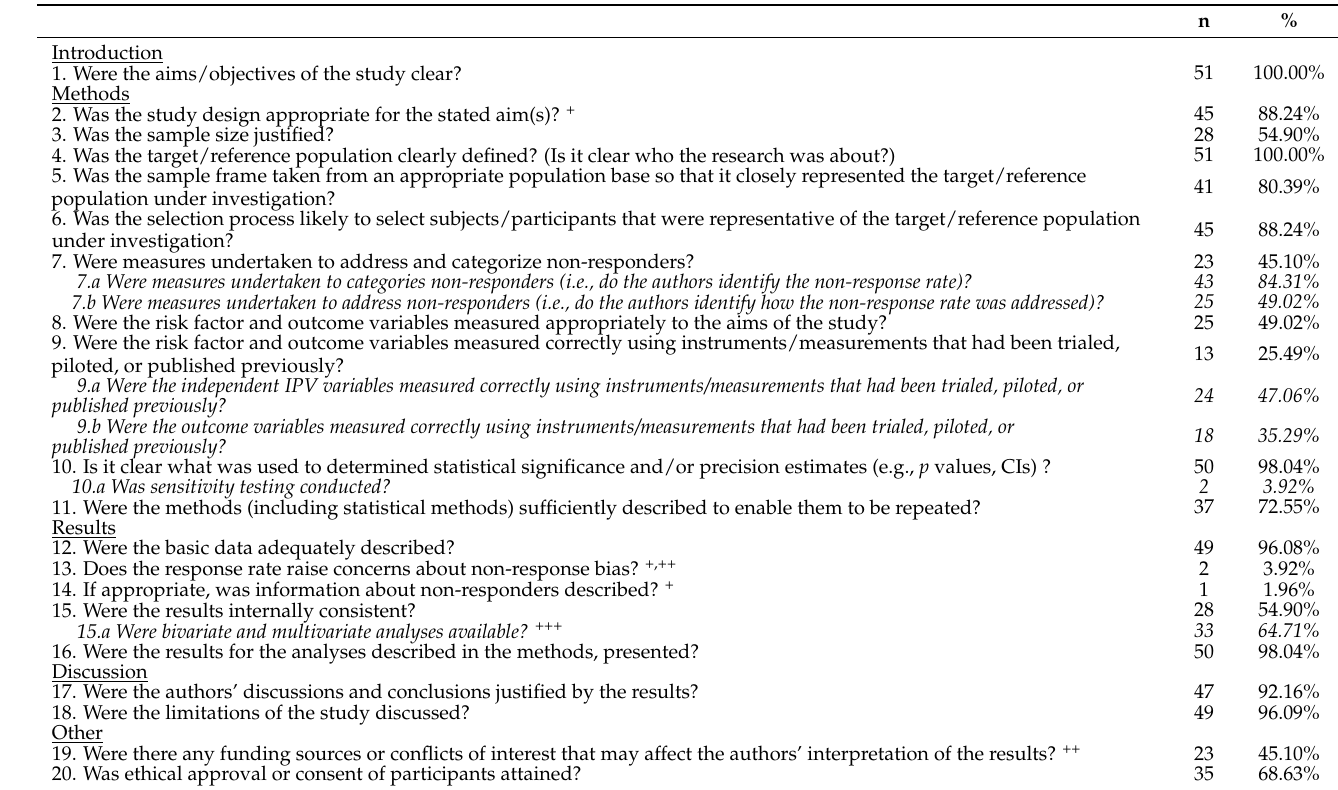
Table 4. AXIS quality assessment of included articles, frequency per item, and quartile distribution of final